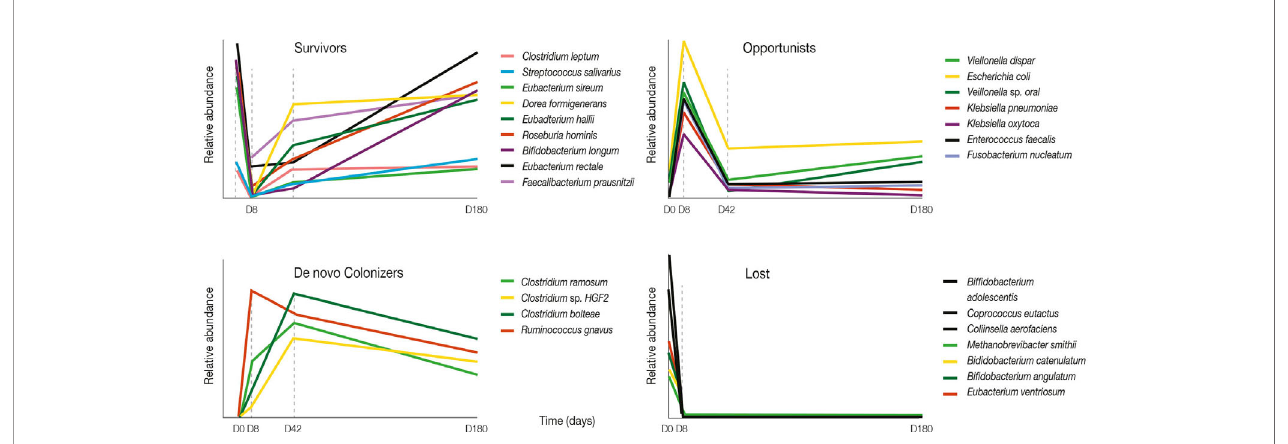
FIGURE 2 | Four-day antibiotic treatment induced large shifts in bacterial abundances. Graphs show relative abundance of representative species according to their pattern of change after four-day antibiotic treatment over a 180-day follow-up period. Adapted from Palleja et al.